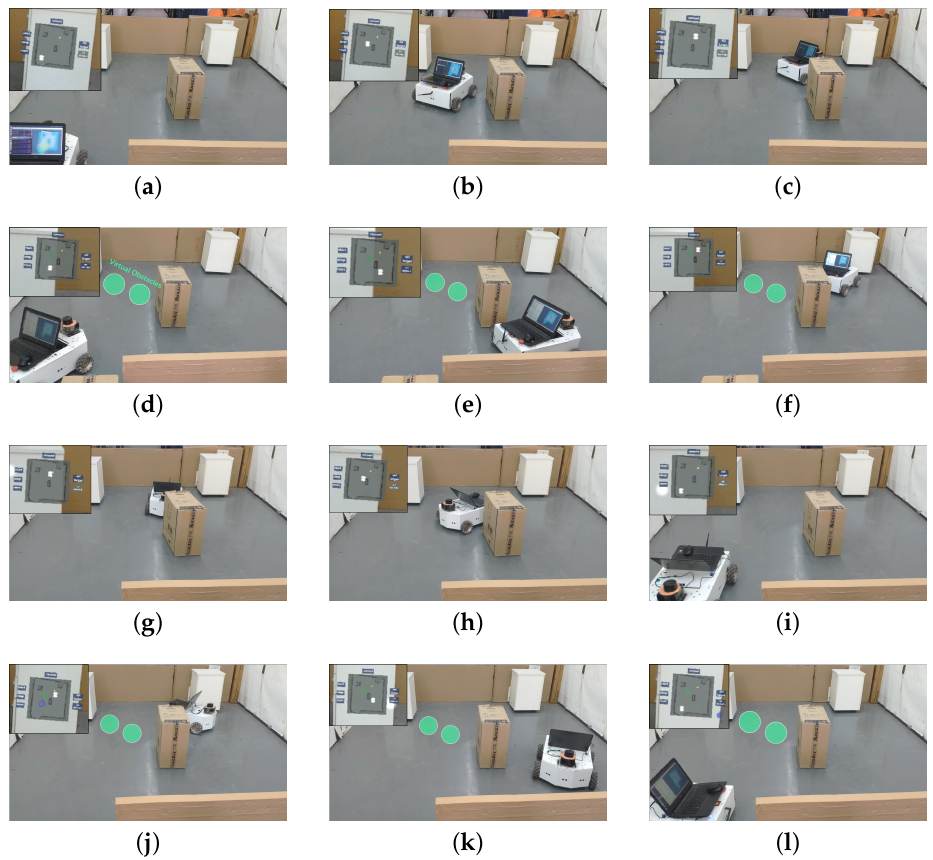
Figure 13. Verifying the results of the experiment with the real omnidirectional mobile robot. The top left corner of each picture is the image in HoloLens. Since HoloLens superimposes virtual objects on a real scene, the cabinet in the real scene can be seen in the image. ( a – f ) The process comparisons of reaching the target point without and with virtual obstacles, respectively. The green circles are the virtual obstacles that do not exist in the real scene and only act on the cost map of the mobile robot. ( g – l ) Comparisons of processes that return to the starting point without and with virtual obstacles,